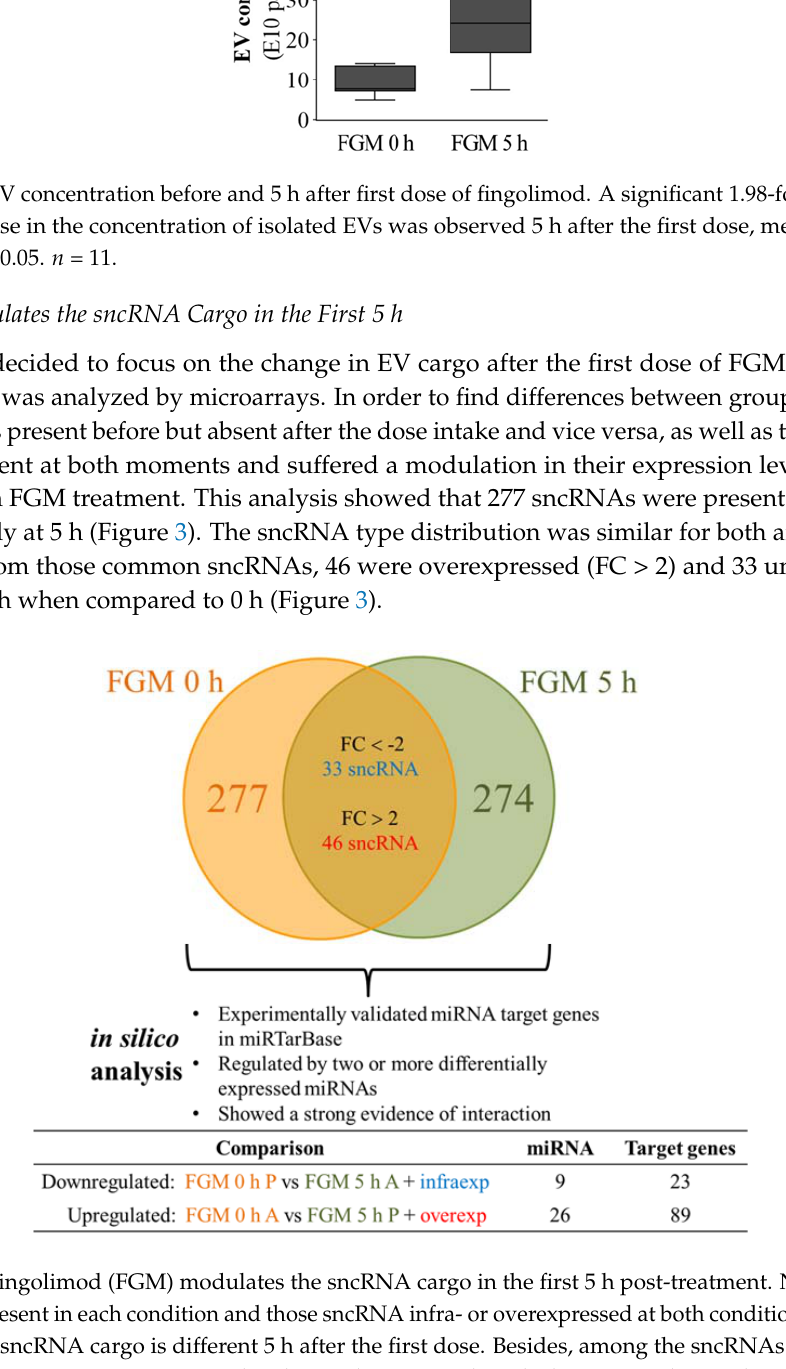
Figure 3. Fingolimod (FGM) modulates the sncRNA cargo in the first 5 h post-treatment. Number of sncRNA present in each condition and those sncRNA infra- or overexpressed at both conditions. Nearly 50% of the sncRNA cargo is different 5 h after the first dose. Besides, among the sncRNAs present in both situations, 46 are overexpressed and 33 underexpressed. In the lower part, the number of miRNAs and their experimentally validated target genes (based on miRTarBase) for the in silico comparisons are shown. A: absent and P: